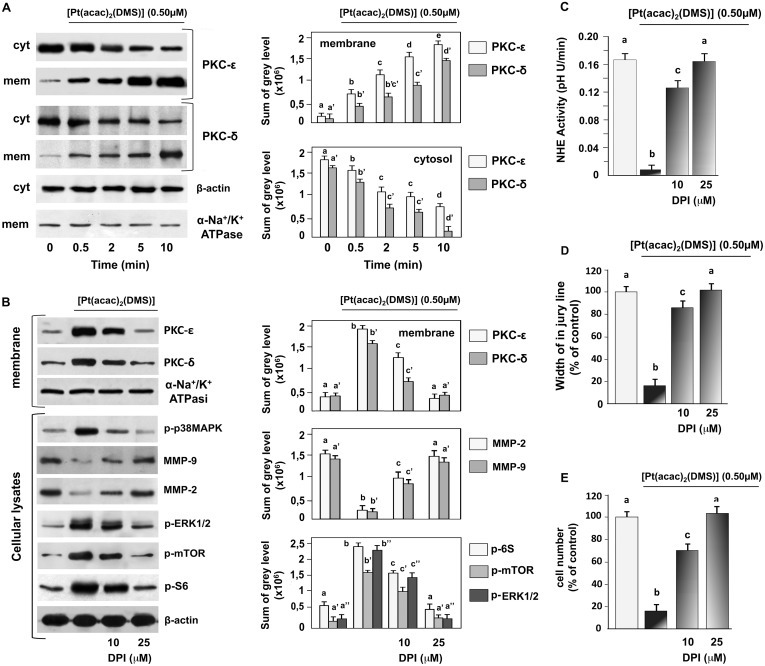
Role of NAD(P)H oxidase in [Pt(acac)2(DMS)] inhibition of SH-SY5Y cell migration and invasion.(A) SH-SY5Y cells were treated without or with 0.50 µM [Pt(acac)2(DMS)] for the indicated times. For PKCs translocation studies, cytosol (cyt) and membrane (mem) fractions were analysed by Western blotting with specific antibodies. The purity of fractions was tested with anti β-actin and anti-α subunit of Na+/K+ ATPase monoclonal antibodies. The figures are representative of four independent experiments and results from densitometry are expressed as mean ± SD (n = 4) of sum of the gray level values. (B–E) SH-SY5Y cells were pre incubated or not with different concentration of DPI and then treated with 0.50 µM [Pt(acac)2(DMS)]. (B) Membrane fractions or cell lysates were analysed by Western blotting with specific antibodies. Control loadings are shown by β-actin and representative immunoblots are depicted; results from densitometry are expressed as mean ± SD (n = 4) of sum of the gray level values. (C) NHE1 activities, after acute exposure to an NH4Cl acid load, were measured, (D) cell migration was examined using wound closure assay and (E) cell invasion was measured using the transwell invasion assay system. The data are means ± S.D. obtained from 4 different experiments. (A–E) P<0.0001 by one-way ANOVA (n = 4); values with shared letters are not significantly different according to Bonferroni/Dunn post hoc tests.